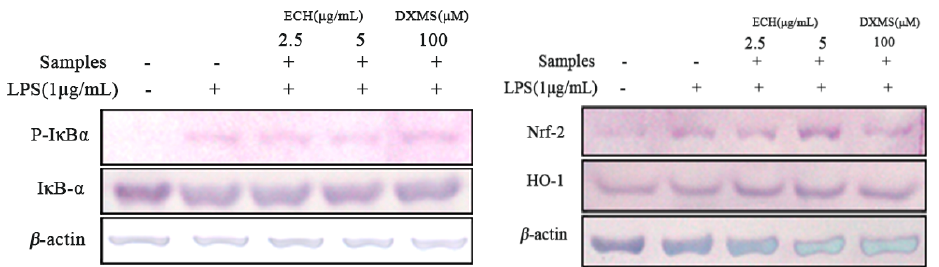
Figure 4. Effect of ECH on the expressions of inflammation and anti ‐ oxidant signaling related proteins in LPS ‐ induced activated RAW 264.7 cells RAW 264.7 cells were pretreated or not with indicated concentrations of ECH for 1 h then were activated with LPS (1 μ g/mL) for 30 min (left) or 6 h (right). Whole cell lysates were analyzed by Western blotting analysis using specific antibodies.